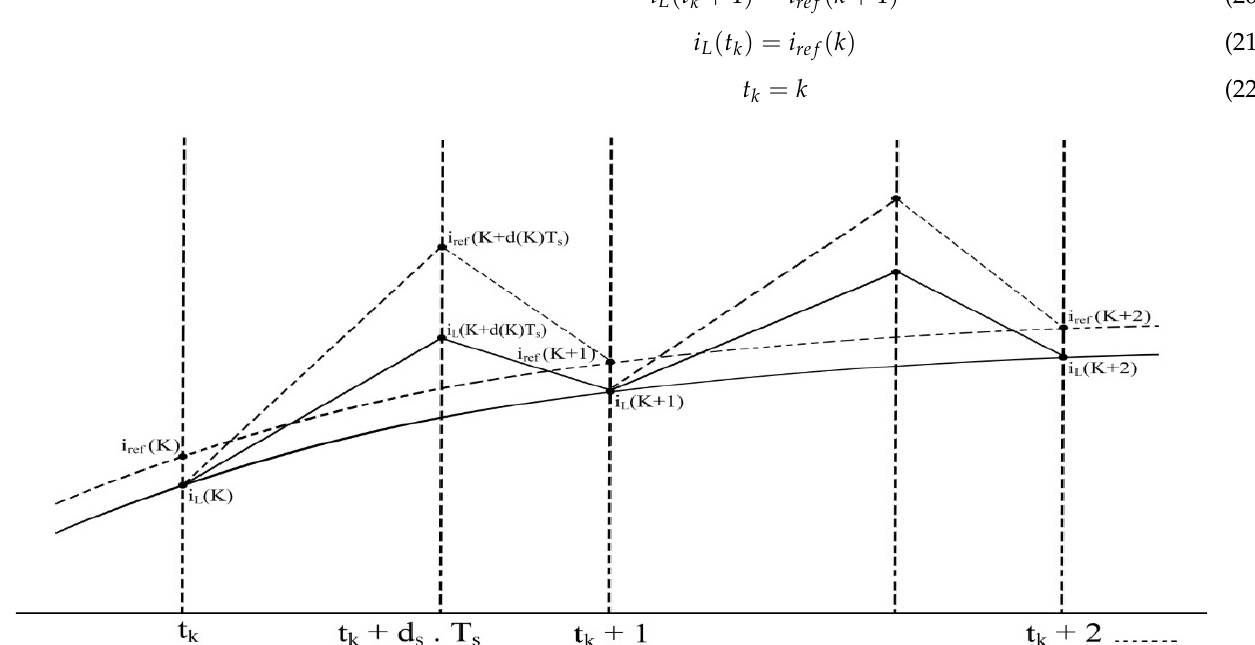
Figure 3. Inductor current and reference current waveforms.